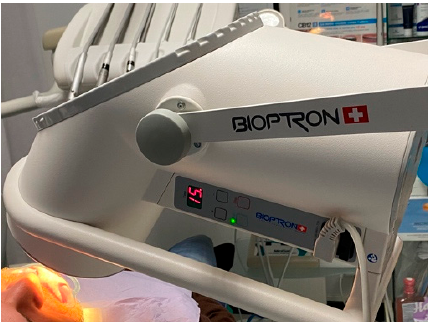
Figure 8. The position of the Bioptron Device and the patient’s face.